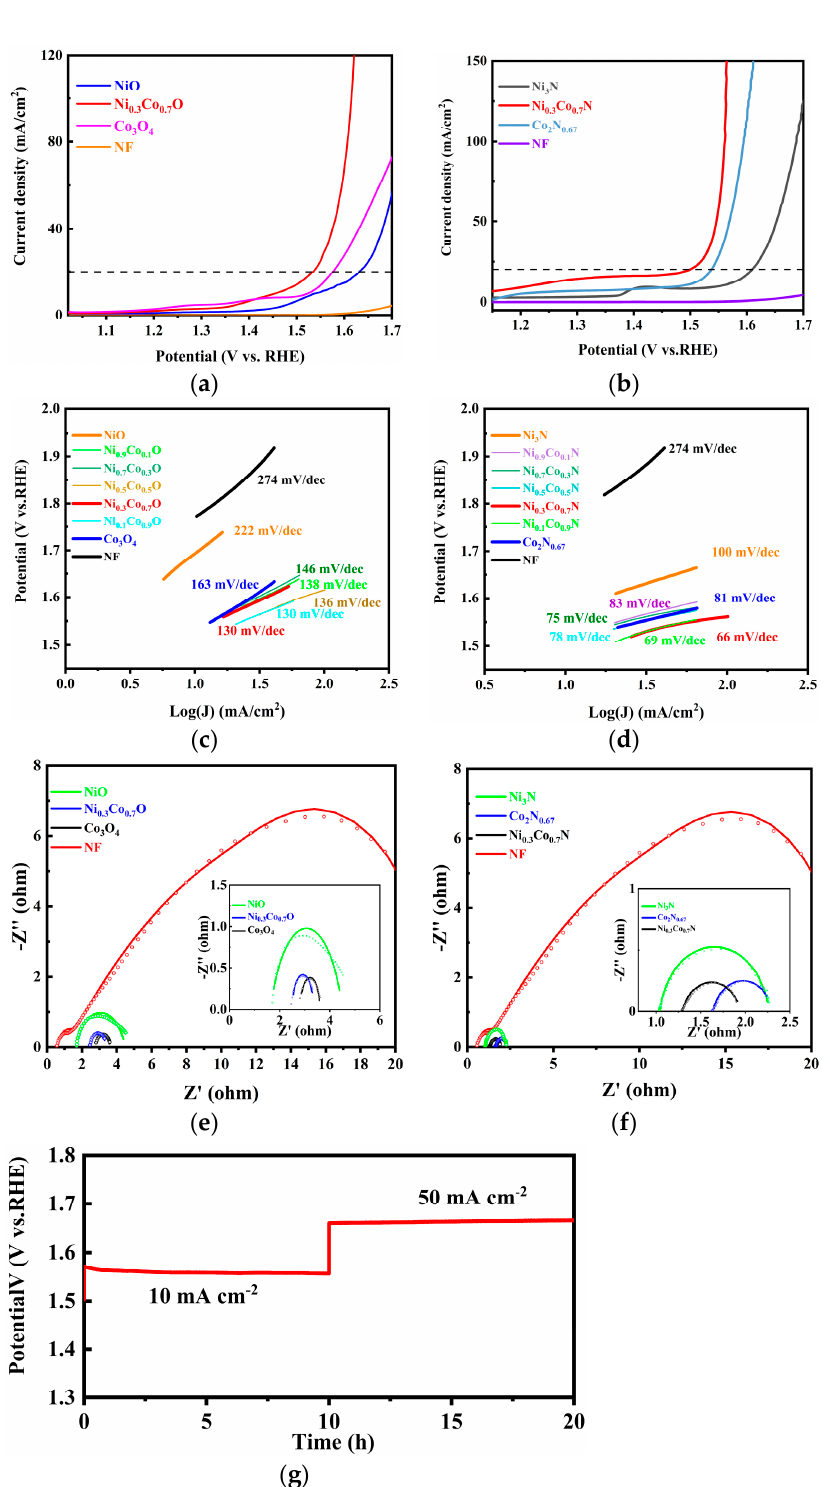
Figure 8. The iR-compensated LSV polarization-curves of ( a ) Ni x Co 1 − x O and ( b ) Ni x Co 1 − x N catalysts; the corresponding Tafel plots of ( c ) Ni x Co 1 − x O and ( d ) Ni x Co 1 − x N catalysts; EIS Nyquist plots of ( e ) Ni x Co 1 − x O and ( f ) Ni x Co 1 − x N catalysts; and ( g ) chronopotentiometric stability test of Ni 0.3 Co 0.7 N in 1.0 M KOH aqueous solution.